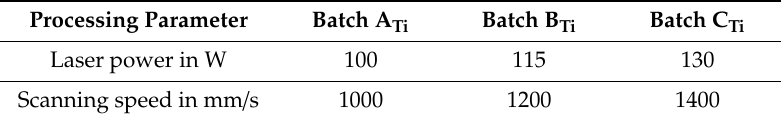
Table 2. Parameter settings for titanium specimens.